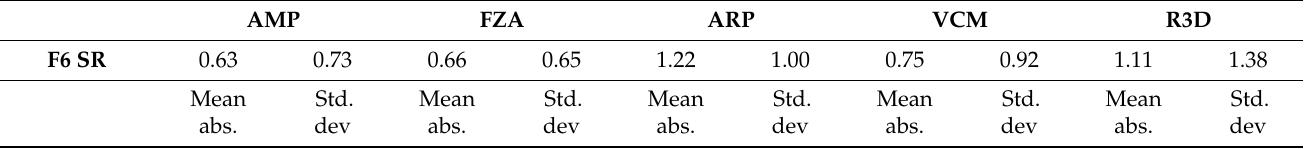
models produced from non-commercial software ranged at about 1 mm. Table 17. Hausdorff distances between the 3D scanning and photogrammetric models from dataset 6 (distances in mm). AMP FZA ARP VCM R3D F6 SR 0.63 0.73 Mean Std. Mean Std. Mean Std. Mean Std. Mean Std. abs. dev abs. dev abs. dev abs. dev abs.